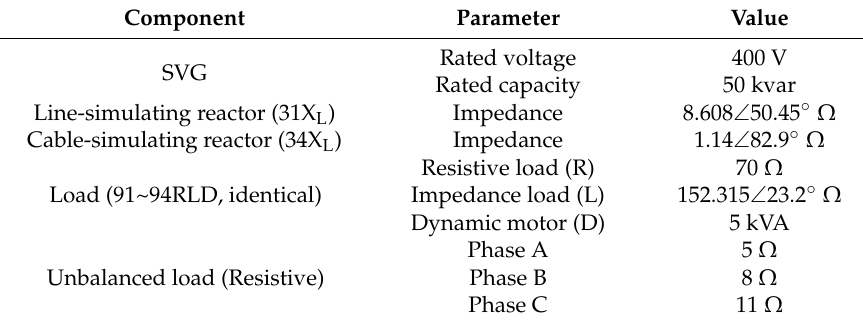
Figure 6. Digital-physical hybrid real-time simulation system used for SVG testing. Table 4. Parameters of physical subsystem used for SVG